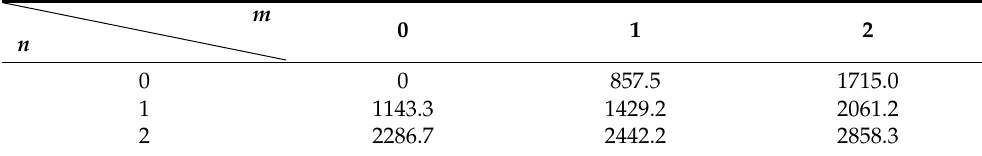
Table 2. Modal frequencies (Hz) of the rectangular chamber.